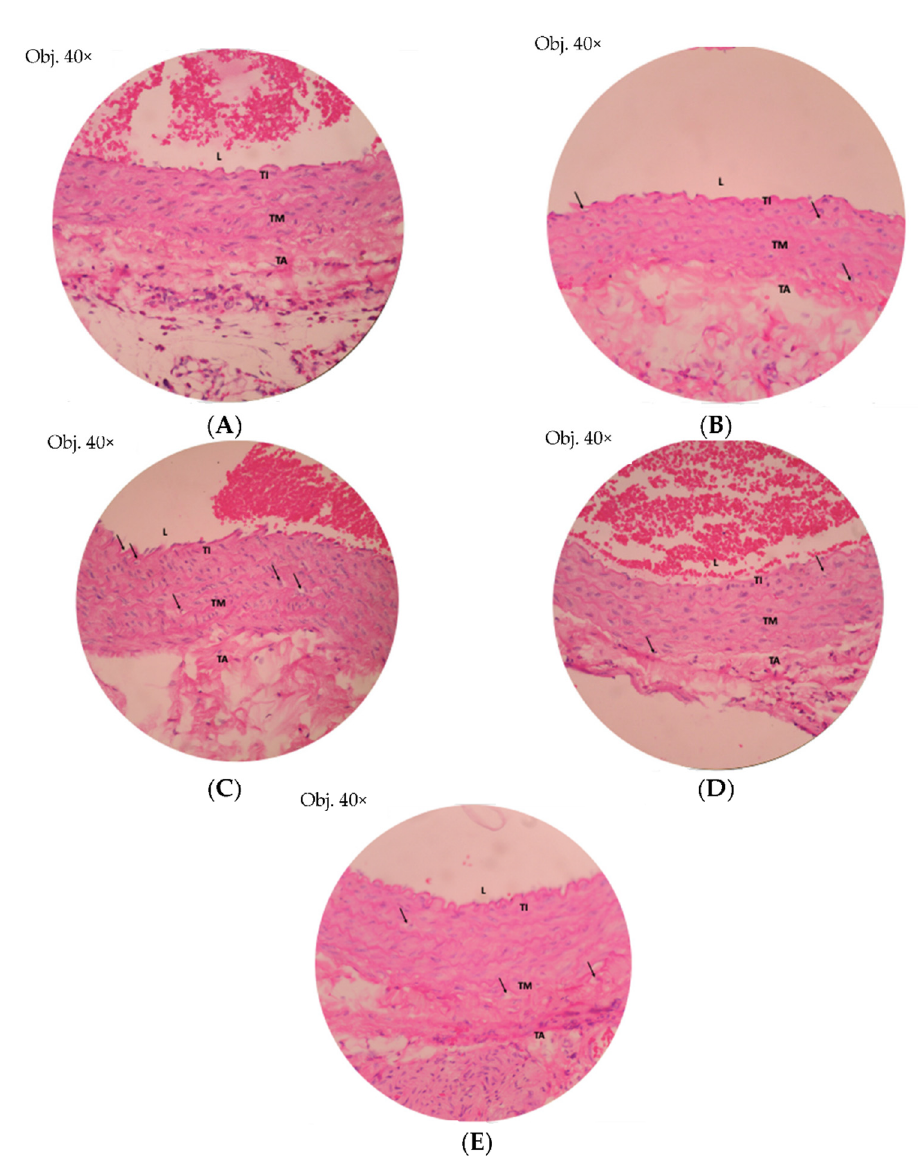
Figure 13. Foam cell in test groups after 2 weeks of treatment. ( A ) Normal, ( B ) Positive, ( C ) Negative, ( D ) TCG, ( E ) NTCG. ( D ) TCG, ( E )